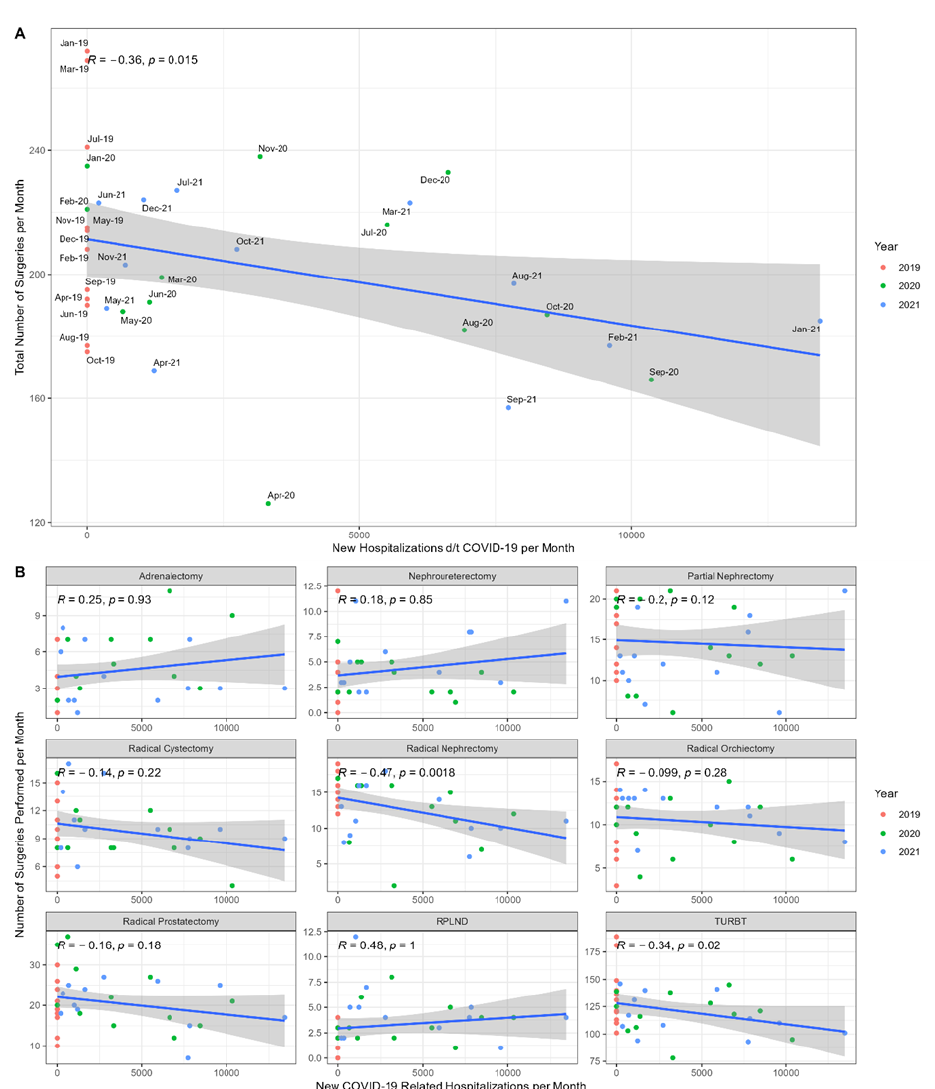
Figure 3. ( A ) Correlation between the total number of urologic surgeries per month and the number of new COVID-19 related hospitalizations per month. ( B ) Subgroup analysis per surgery